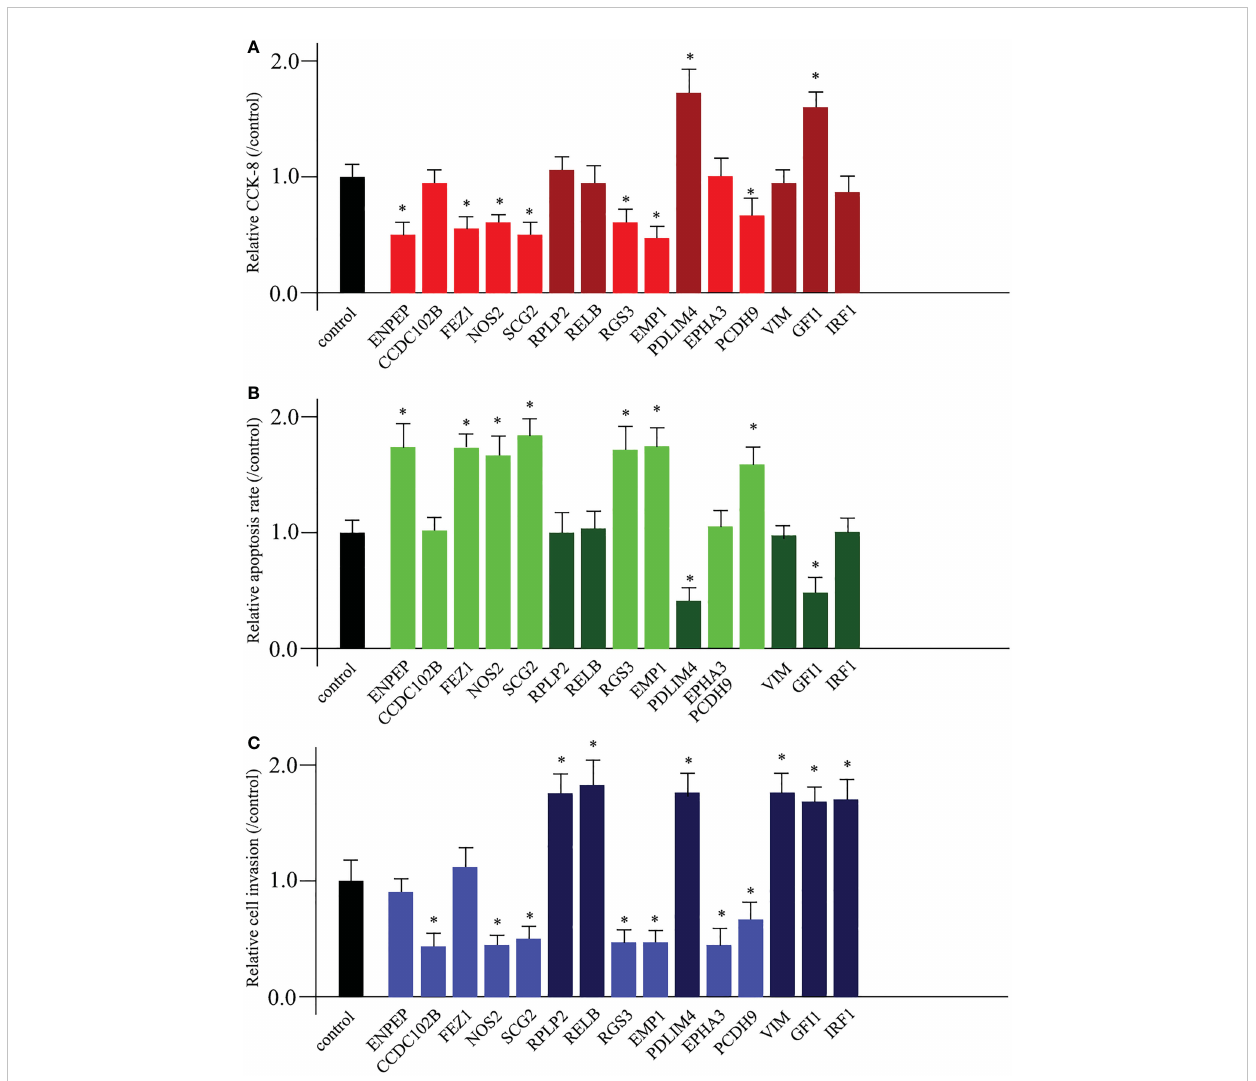
FIGURE 5 Diverse functions of TME prognostic genes for breast cancer development. The cell proliferation analysis (A) , the cell apoptosis examination (B) , and the cell invasion or migration measurement (C) comparing untreated control and 15 TME prognostic gene siRNA-transfected breast cancer cells. * as an indication of P < 0.05 compared with internal